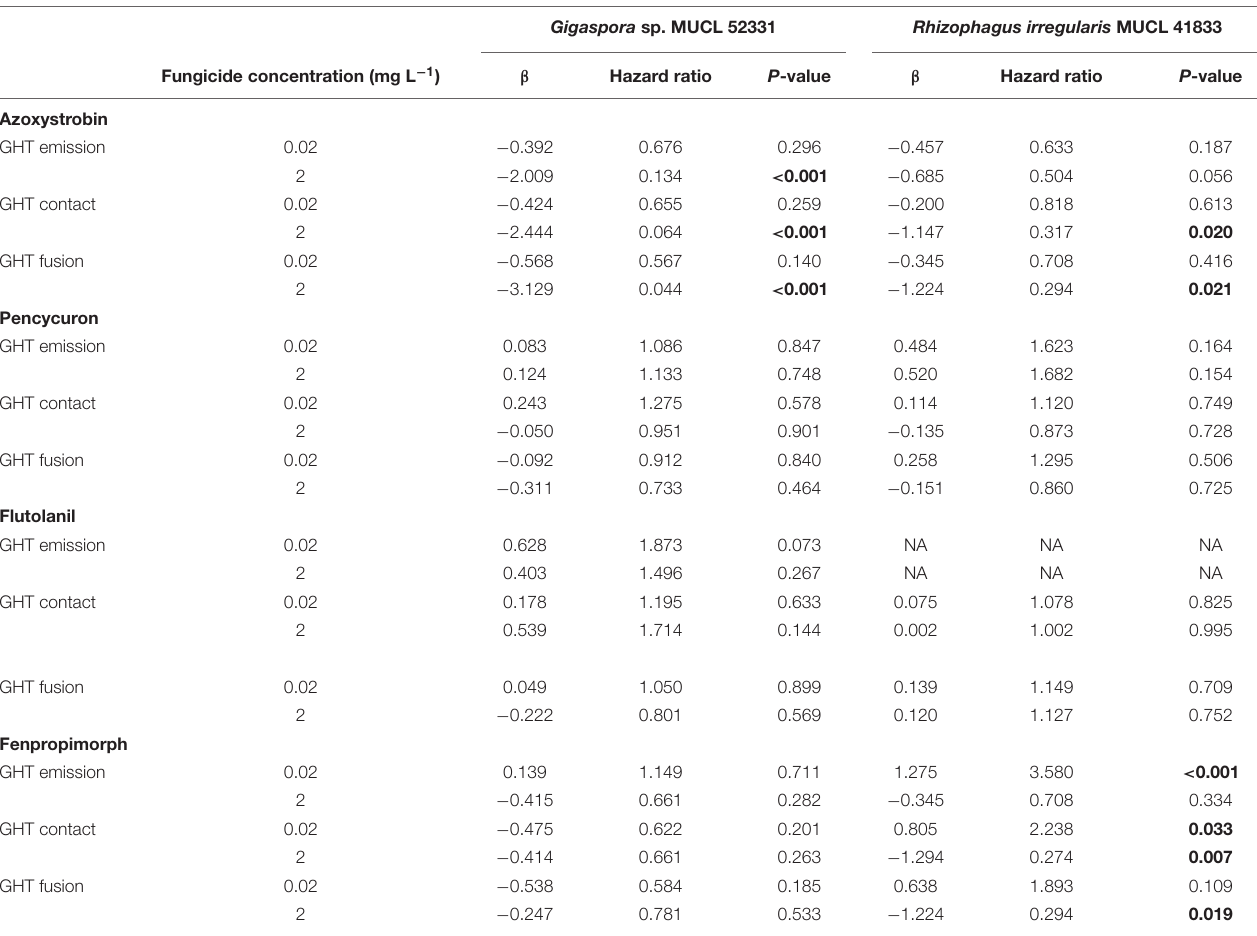
TABLE 2 | Results of Cox proportional hazards regression analysis on growing hyphal tips (GHTs) emission, contact and fusion events of the hyphal healing mechanism (HHM) for Gigaspora sp. MUCL 52331 and Rhizophagus irregularis MUCL 41833 in presence of increasing concentrations of azoxystrobin, pencycuron, flutolanil and fenpropimorph (0.02 and 2 mg L − 1